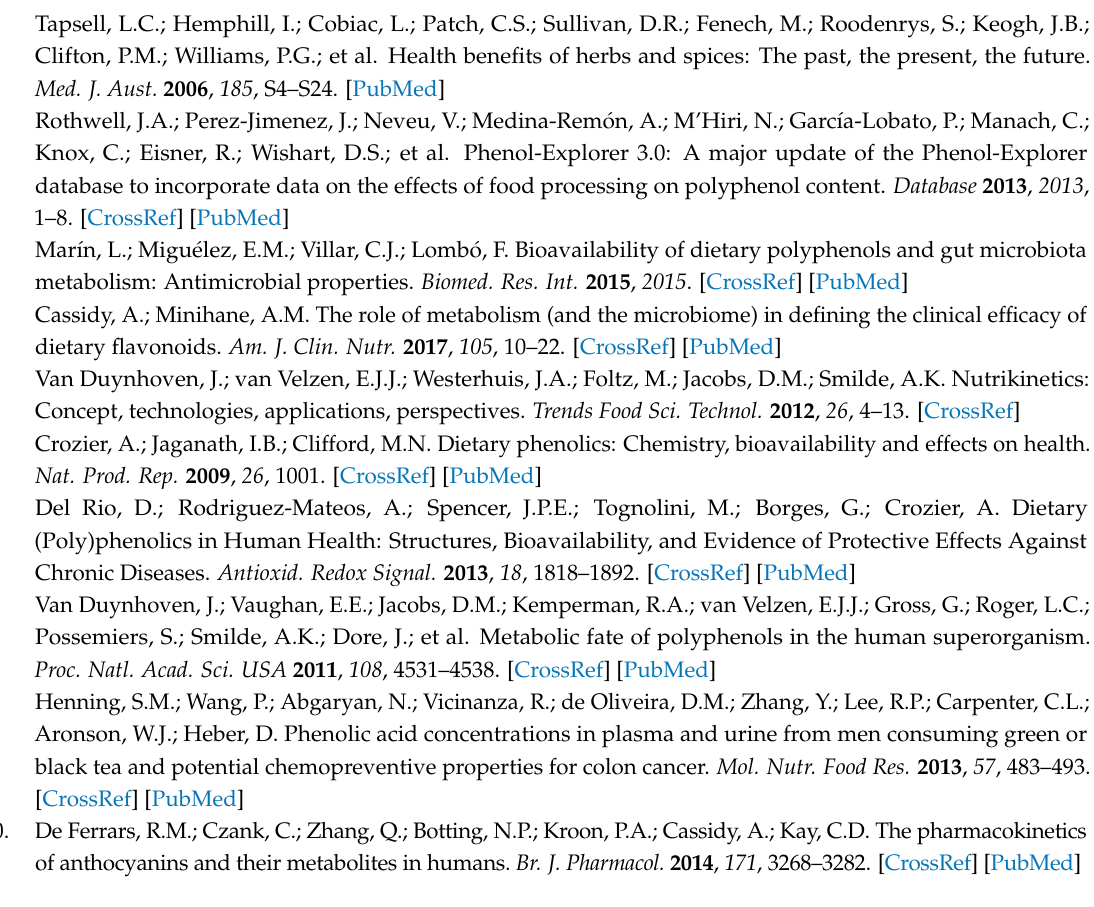
doses. Table S1: List of polyphenols in the spices and vegetables used in study. Table S2: Mass spectrometry and method validation parameters. Table S3: Nutrikinetic models selection with Akaike information